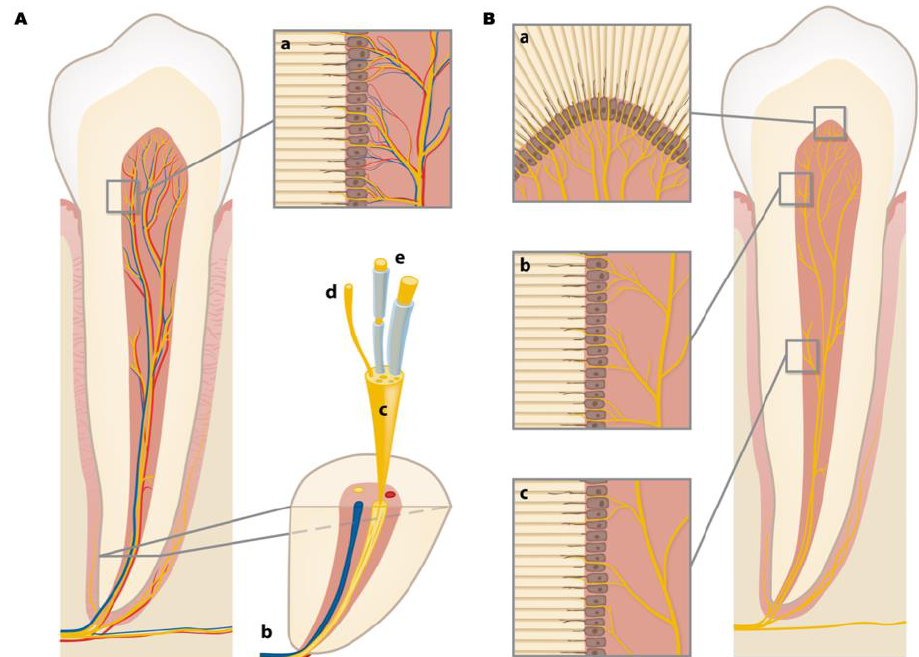
Figure 1. ( A ) Pulp-dentinal complex vascularization and innervation. (a) blood vessels (red and blue) and sensory nerves (yellow) from pulp chamber to dentinal tubules forming the plexus of Raschkow; (b) neurovascular bundle at tooth apex; (c) nerve bundle; (d) unmyelinated nerve fiber; (e) myelinated nerve fibers; ( B ) tooth innervation; (a) the coronal aspect of the pulp chamber presents highly packed nerve terminals that progressively decrease in cervical (b) and apical direction (c) nerve terminals both end in the odontoblastic layer and within the dentinal tubules.